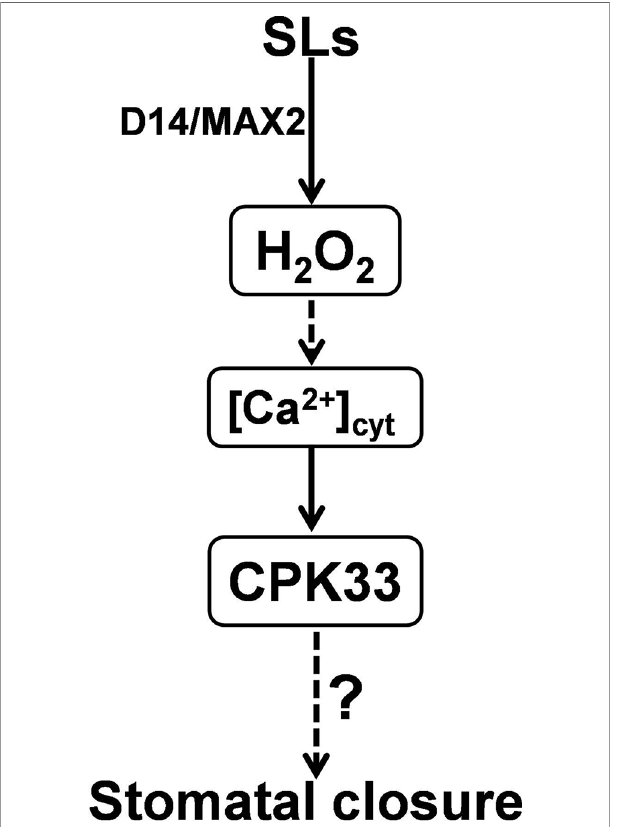
FIGURE 6 | A working model for CPK33-mediated strigolactone (SL) signaling in guard cells. Following perception by D14 and MAX2, SLs stimulate the production of H 2 O 2 that possibly activates the Ca 2+ transducer CPK33 which likely modulates anion and potassium channels to promote stomatal closure. The question mark stands for an unknown molecule(s) that is downstream of CPK33 in SL-mediated stomatal closure. It remains to be explored whether and how SLs and/or SL-induced H 2 O 2 could promote cytosolic Ca 2+ which is presumably sensed by CPK33 in SL-mediated guard cell